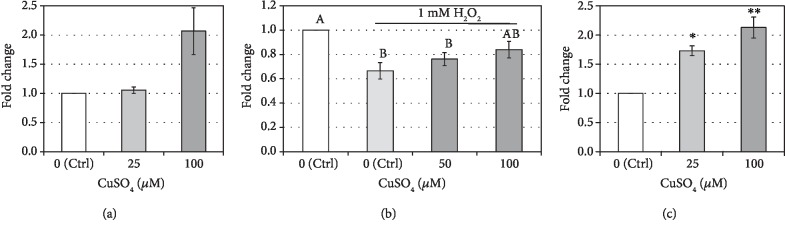
The effect of cupric sulfate on copper-dependent enzyme activity in hASCs. (a) The effect of cupric sulfate on superoxide dismutase SOD1 activity. Data presented as means ± SEM; n = 3. (b) The effect of cupric sulfate on hydrogen peroxide-induced oxidative stress damage measured in MTT test. Data presented as means ± SEM. Statistical significance is indicated by letters: there is no significant difference between groups with the same letter (p > 0.05). Analyzed using tests for related groups in comparison to the control (Ctrl) + 1 mM H2O2; n = 6‐9. (c) The effect of cupric sulfate on lysyl oxidase activity. Data presented as means ± SEM. Analyzed using tests for related groups in comparison to the control (Ctrl); ∗p < 0.05 and ∗∗p < 0.01; n = 8‐9.